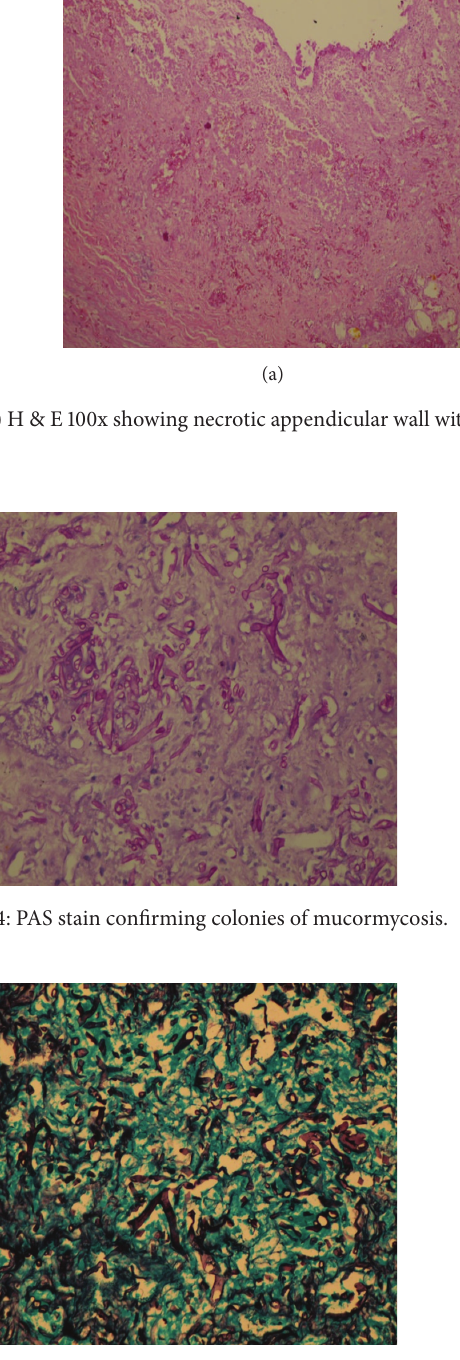
Figure 5: GMS stain confirming the broad aseptate hyphae of